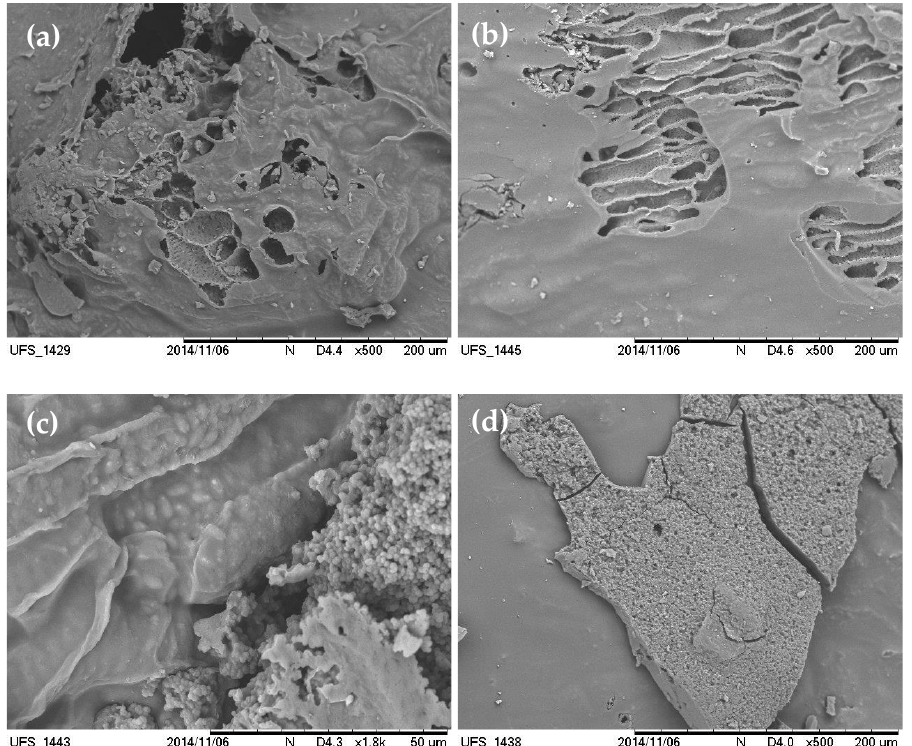
Figure 7. SEM of biochar and biocatalyst immobilized by different techniques: ( a ) biochar, ( b ) immobilized lipase by physical adsorption (PA) and ( c , d ) immobilized lipase by covalent binding ( c , b ).